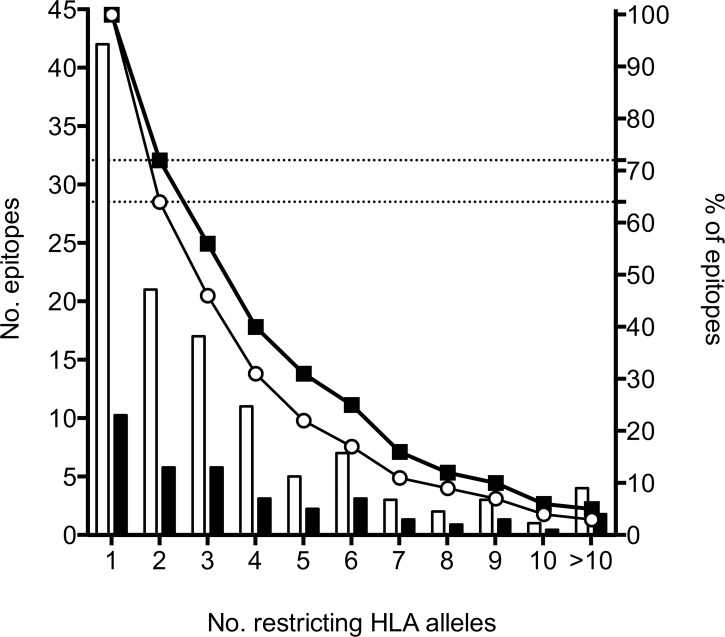
Promiscuity of HLA restrictions.Number of epitopes identified (left y-axis) and the corresponding number of restricting HLA alleles per epitope (x-axis). Percentage of epitopes (right y-axis) restricted by ≥ indicated number of HLA alleles. All restrictions identified (open bars and circles). Restrictions in epitopes tested in ≥2 subjects (black bars and squares).